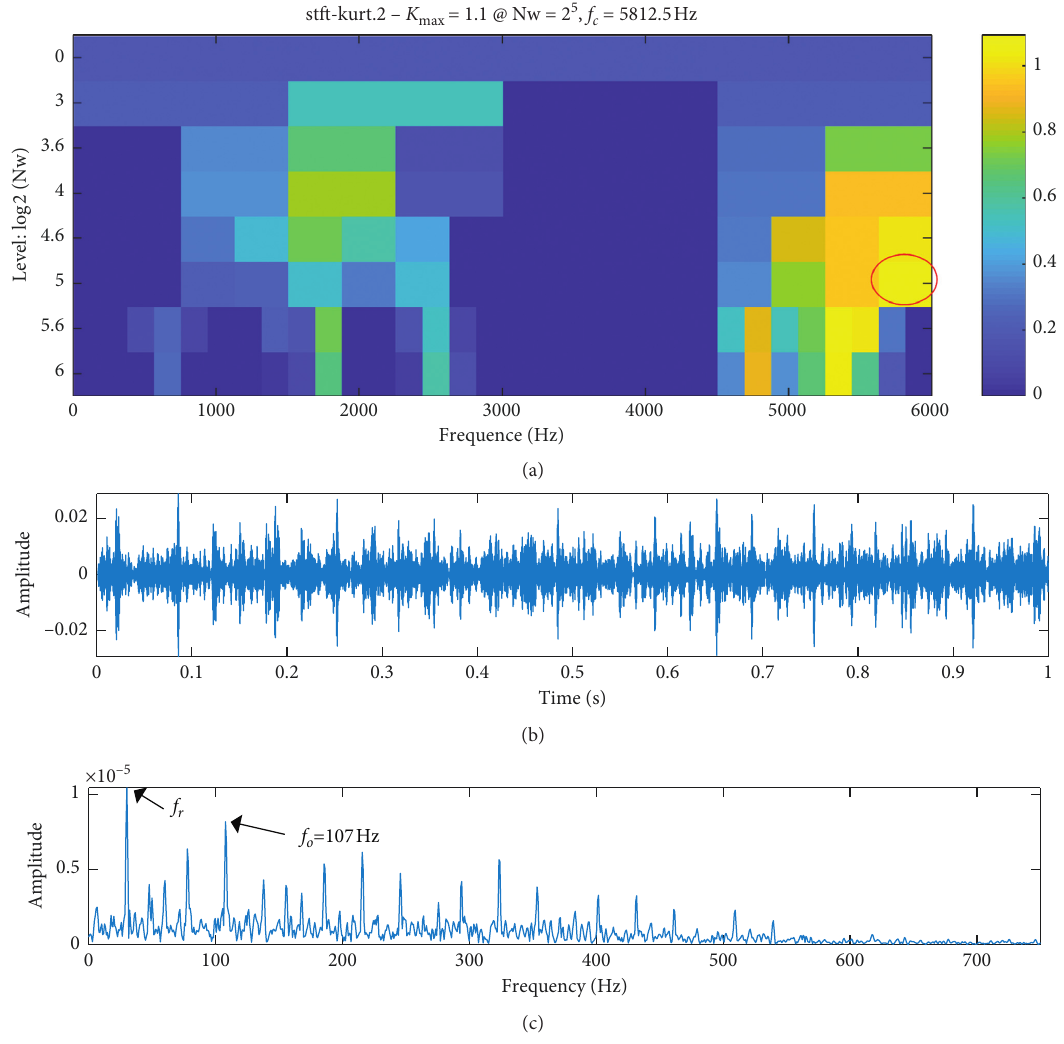
Figure 25: Experimental data in Figure 21(a) processed by the SK: (a) the paving of kurtosis values and (b) the signal filtered by frequency band (expressed by a solid read circle); (c) envelope spectrum of the filtered